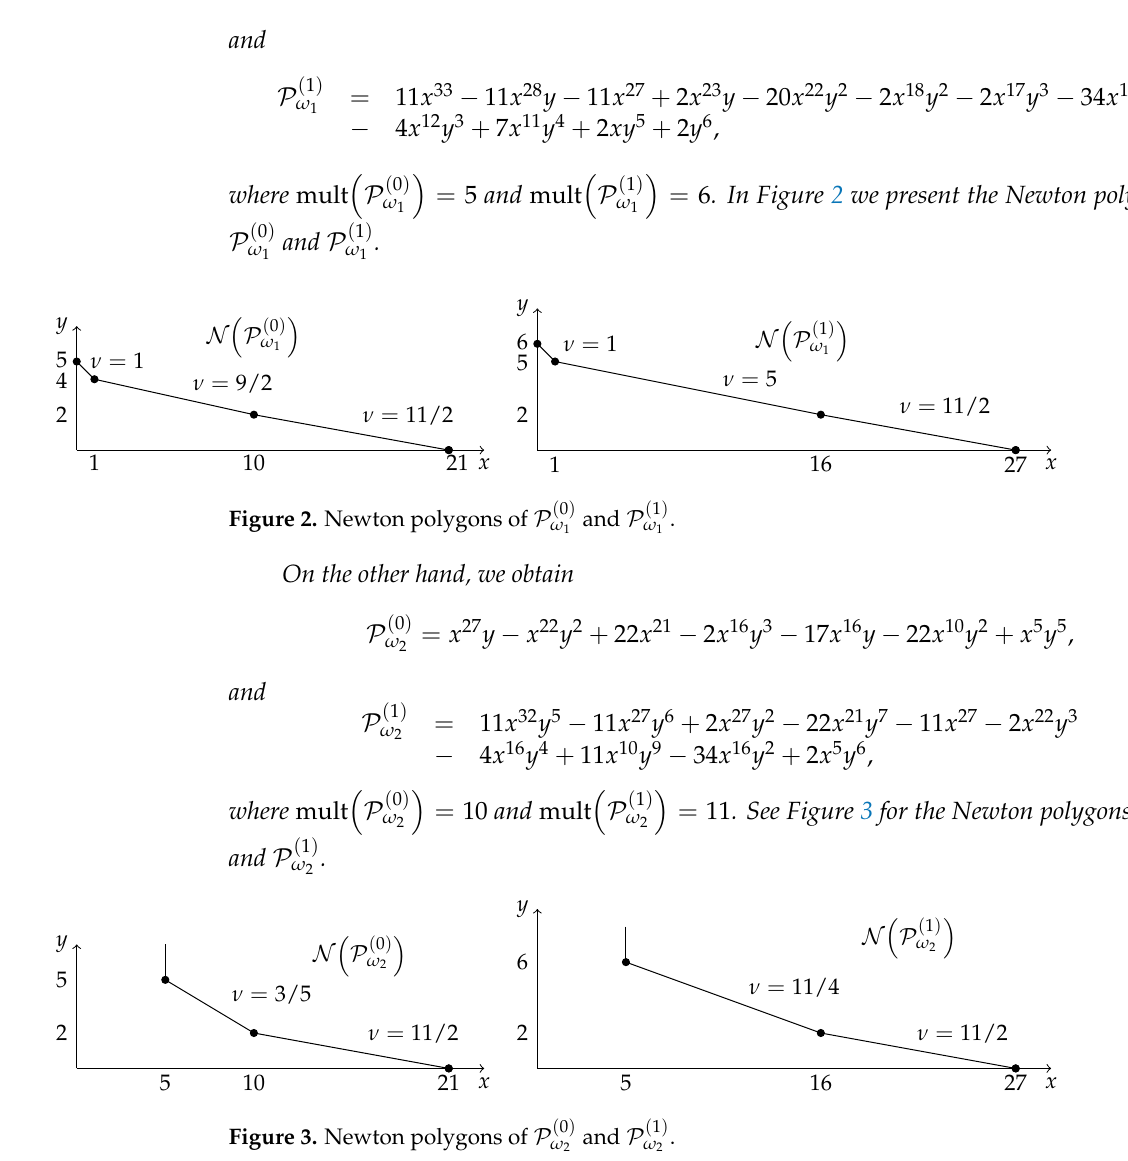
Figure 3. Newton polygons of P